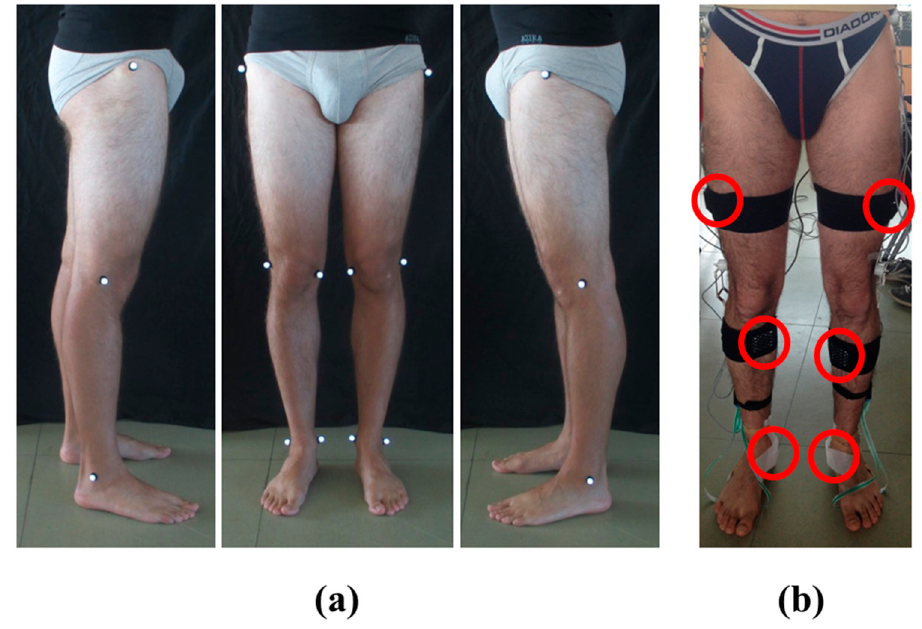
Figure 1. Subject preparation for the protocol: ( a ) Photos from the left, front, and right side of the subject with the reflective markers placed on both lower limbs; ( b ) Placement and fixing of the six sensors on the subject’s lower limbs.